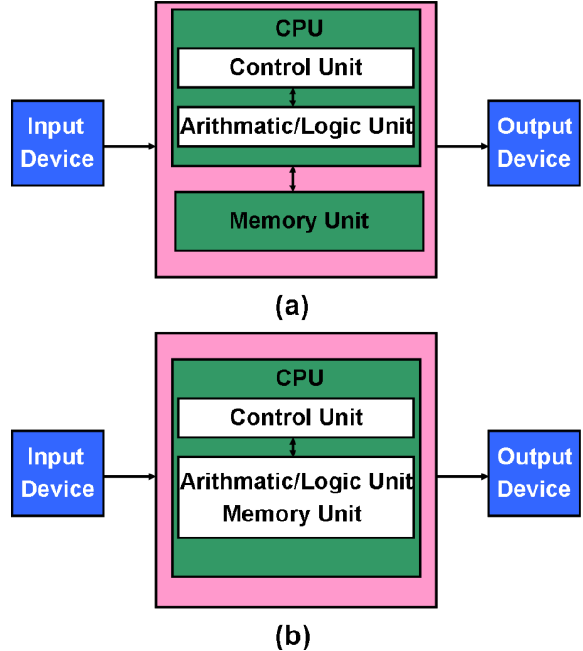
Figure 1. Computer architectures with ( a ) a von Neumann structure and ( b ) a non-von Neumann structure. Note that data need to be retrieved from conventional memory first and transferred to the central processing unit (CPU) for computation when using a von Neumann structure. For non-von Neumann structures, the data can be stored and executed simultaneously inside the computational memory.